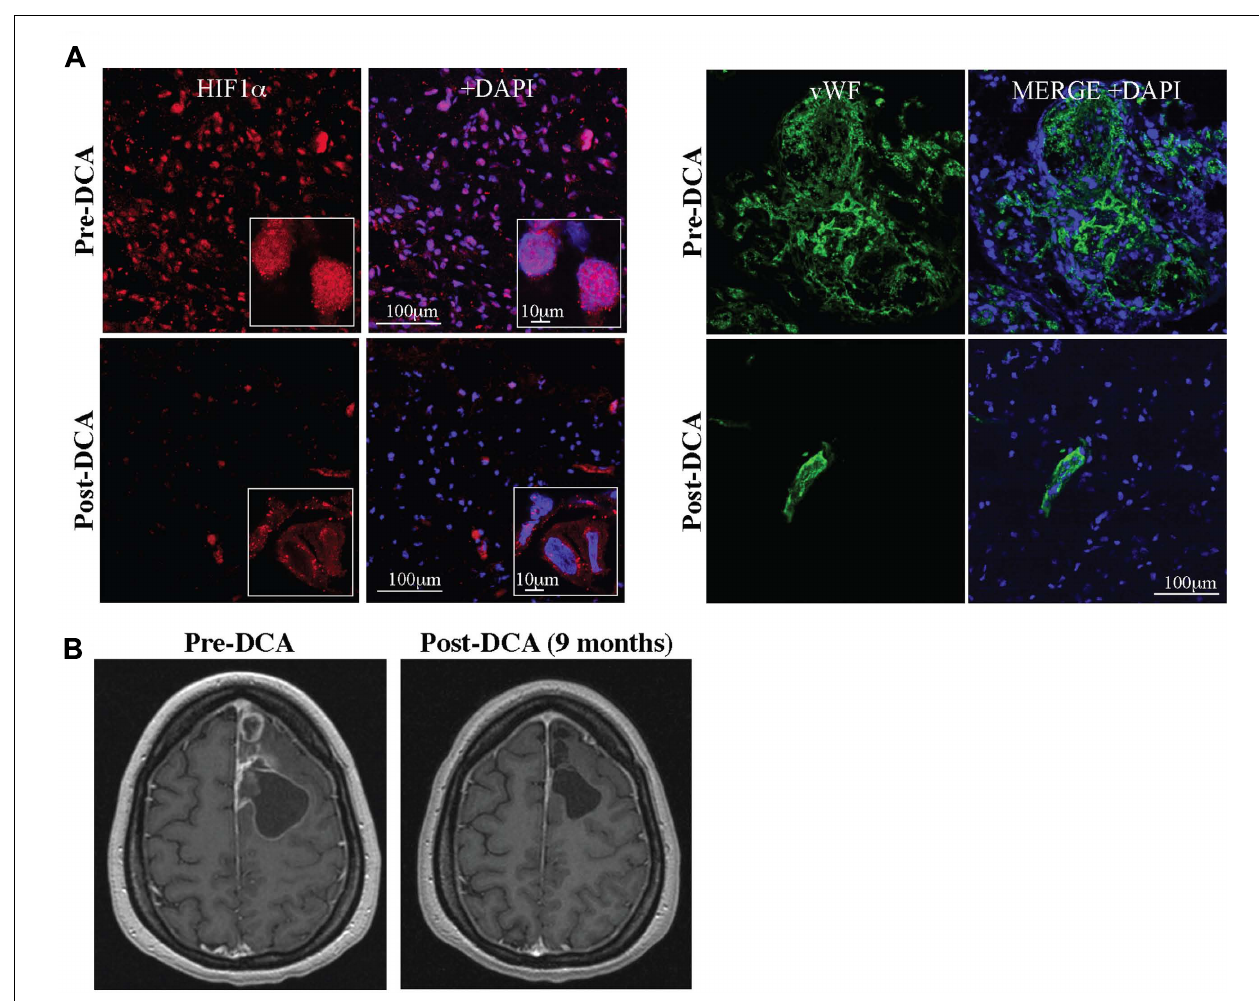
FIGURE 4 | (A) DCA decreases nuclear localization of HIF1 α (HIF1 α , red; merged with DAPI, blue; right) and angiogenesis in GBM (vWF, green; merged with DAPI, blue; right). (B) DCA decreases tumor growth in a patient with GBM after 9 months of treatment. Figure modified with permission from (Michelakis etal.,